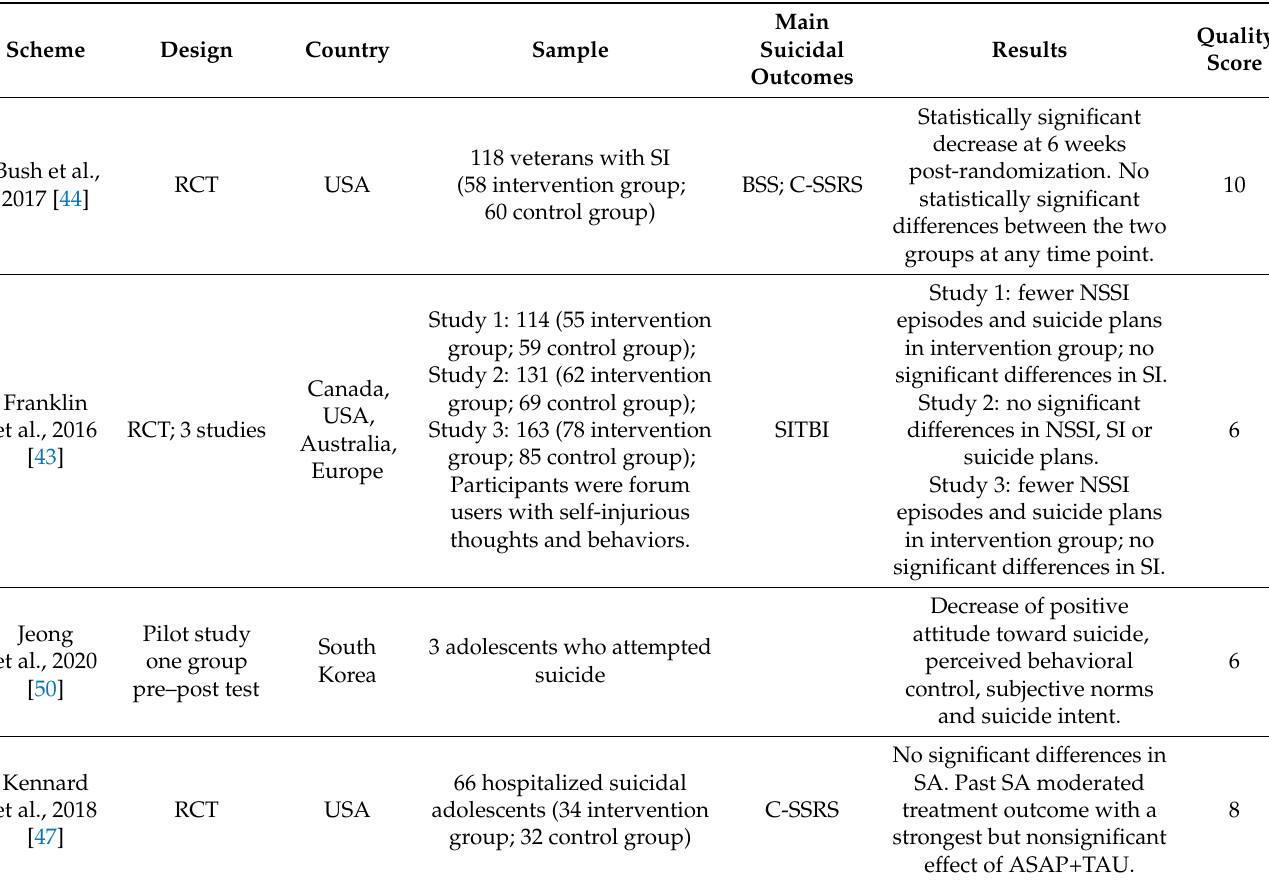
Table 2. Studies on the efficacy of mobile